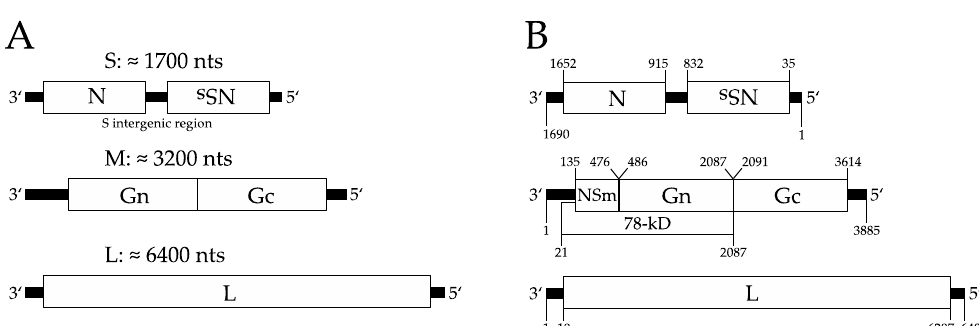
Figure 1. Phlebovirus genome organization. ( A ) The genes encoded in the three strands of a typical phlebovirus genome are represented by open boxes labeled with each gene’s abbreviation and the average size of each strand. The untranslated regions are represented by a thick black bar. The ambisense nature of the S strand is highlighted by the upside down name of the non ‐ structural protein on S segment (NSs); ( B ) The three strands of Rift Valley fever virus (RVFV, strain MP ‐ 12) are shown with the nucleotide labels representing each coding region. The L, M, and S strands correspond to the GenBank nucleotide entries, DQ375404, DQ380208, and DQ380154, respectively. In addition to the proteins encoded by all phleboviruses, some, including RVFV, also code for a nonstructural protein called NSm upstream of Gn and Gc, thus explaining the relative increase of the M strand genome length (3885 nts for RVFV vs. a 3200 nts average).